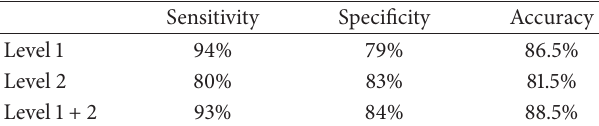
Table 5: Results obtained using the proposed feature in S channel.